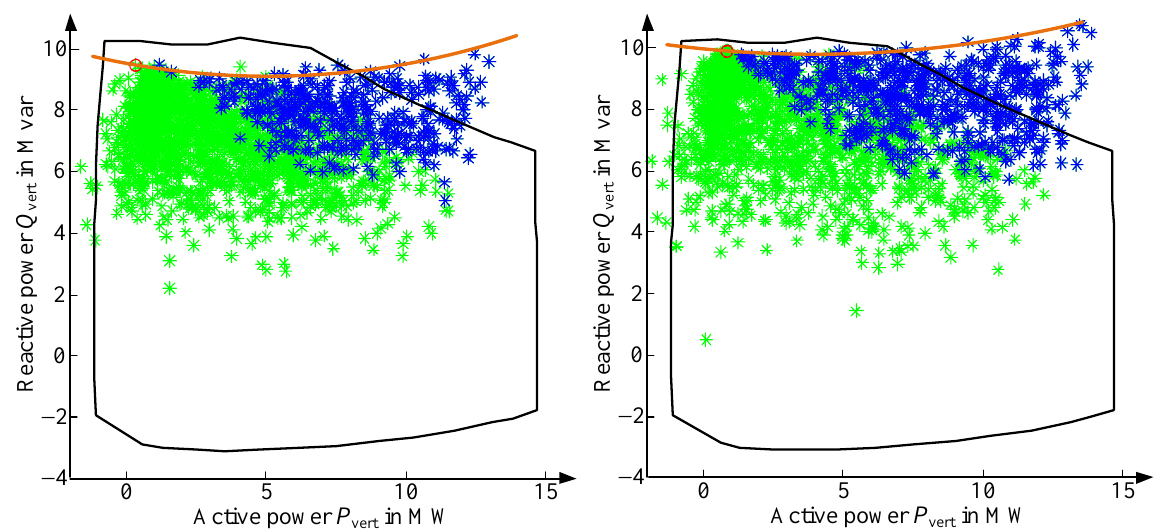
( a ) Particle swarm position at iteration step t = 20 before the ( b ) Particle swarm position at iteration step t = 40 before the set-to-limit operator set-to-limit operator Figure 8. Convergence of the PSO for sampling set-point of P vert,sp = 1.5 MW and α = 0, β =